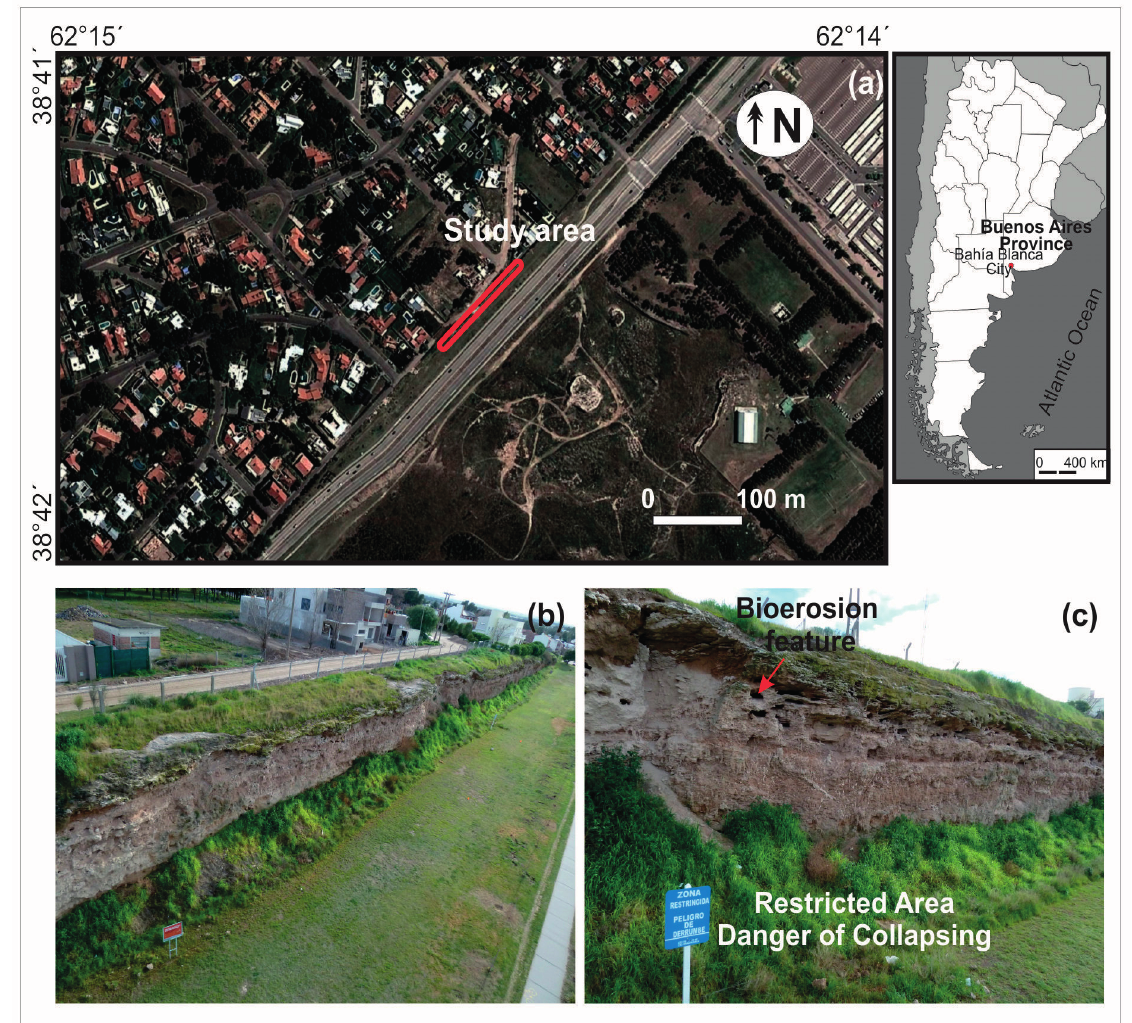
Figure 1. ( a ) Location map of the study area; ( b , c ) Aerial views of the bioeroded cliffy